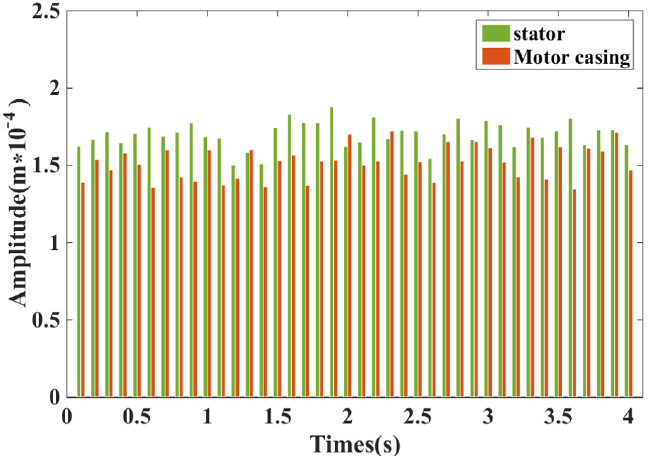
Figure 23. Casing and stator vibration characteristics of DDSRG at rated speed.